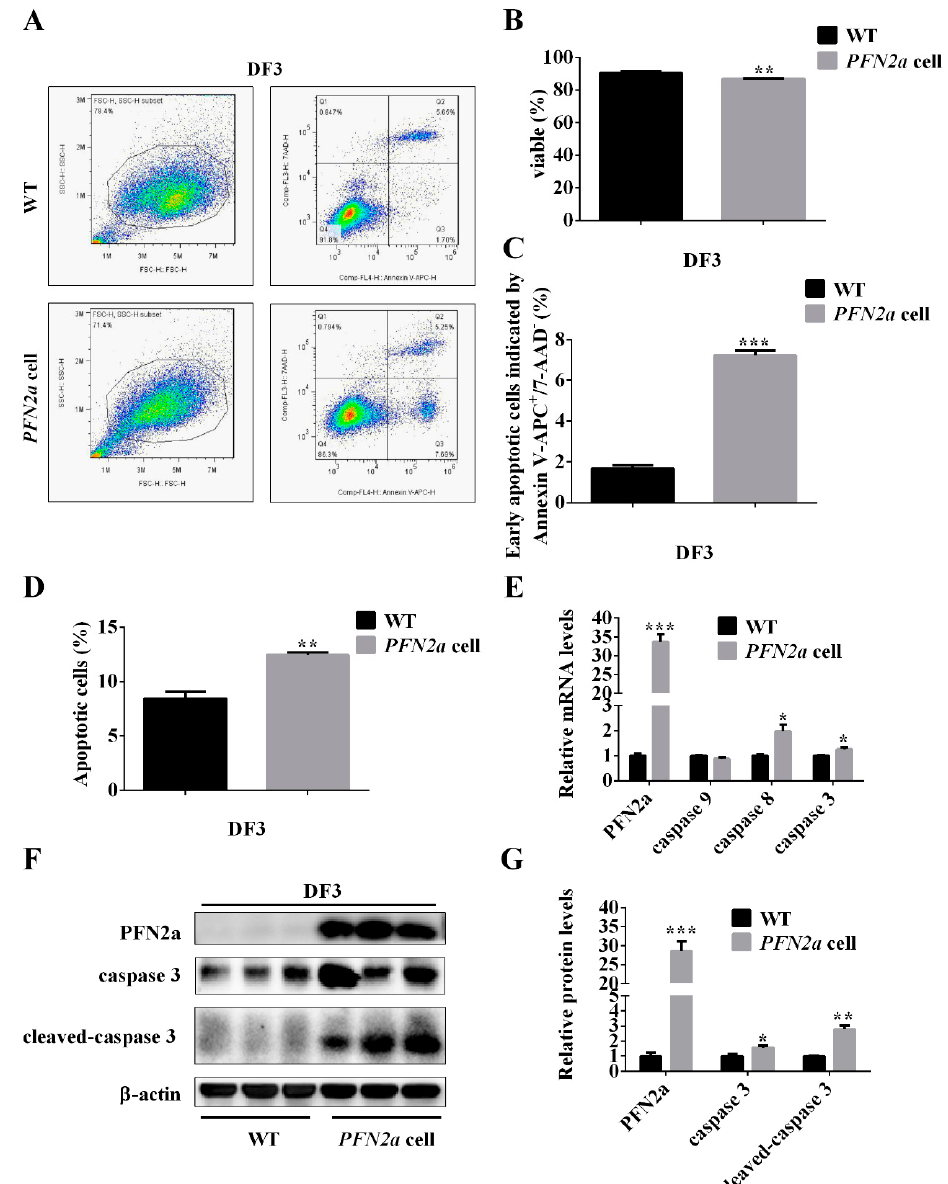
Figure 4. PFN2a overexpression promoted apoptosis during C2C12 myogenic differentiation. ( A